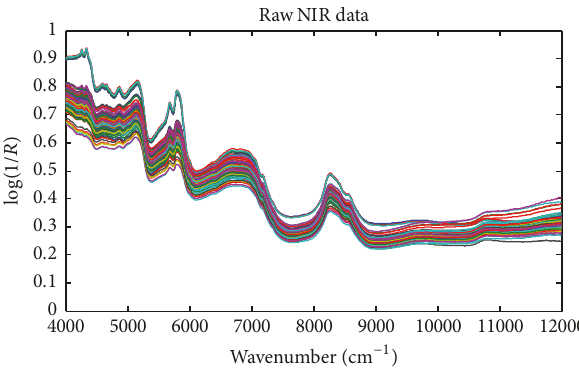
Figure 1: The raw NIR spectra of the 145 sesame seed samples.